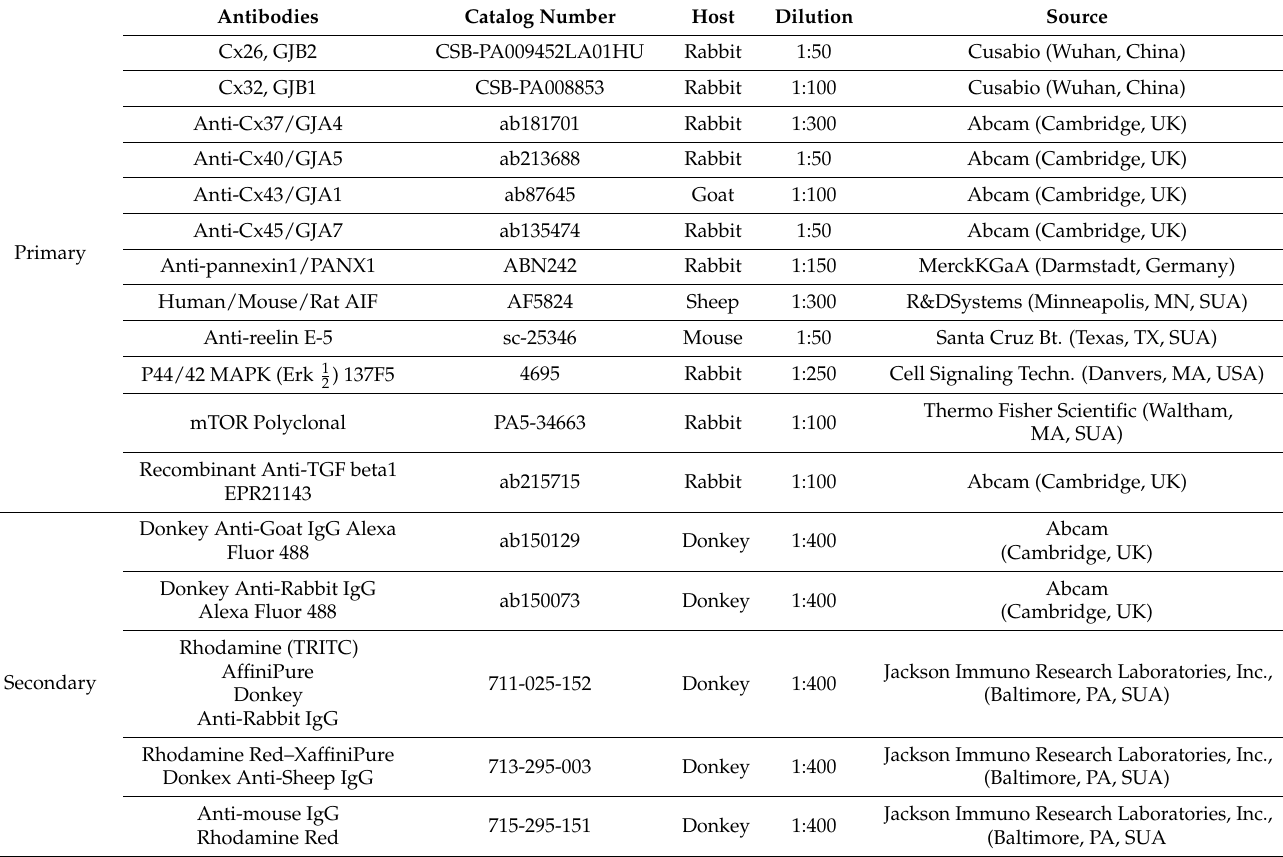
Table 1. Primary and secondary antibodies used in the